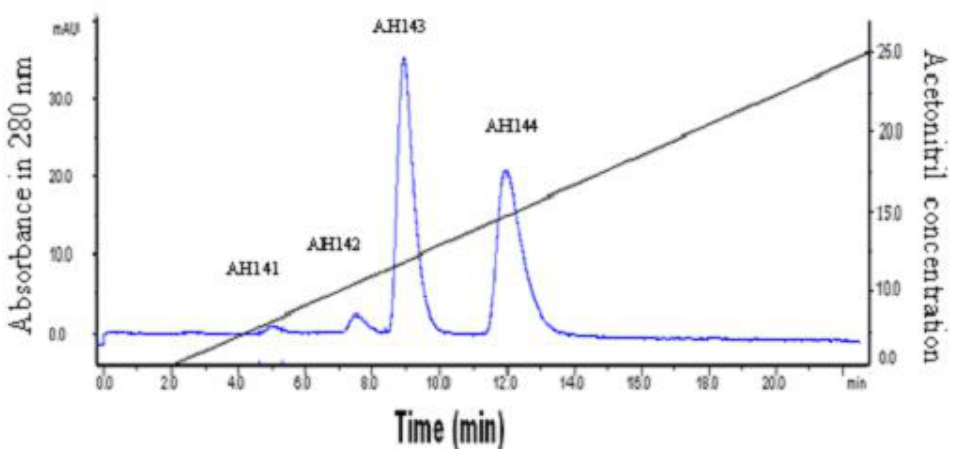
Figure 3. HPLC chromatography of AH14 fraction obtained from DEAE-Sepharose chromatography. AH14 was applied on a HPLC C18 column equilibrated with solvent A (H O, 0.1% TFA) and eluted with a concentration gradient of solvent B (acetonitrile, 2 0.1% TFA) from 0 to 30%, at a flow rate of 0.5 mL/minute during 30